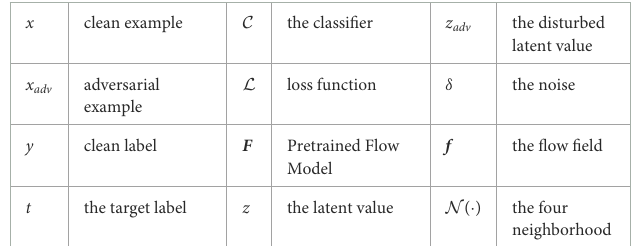
TABLE 1 The notations used in this